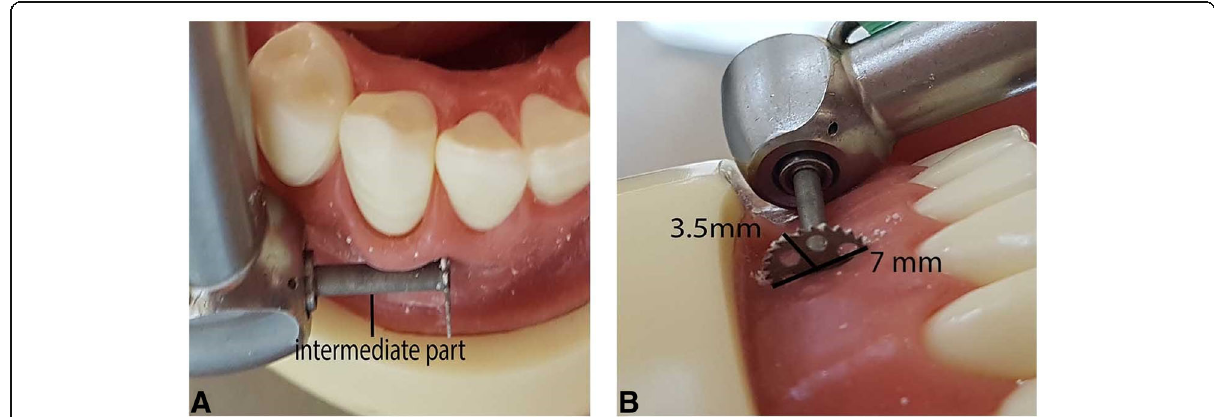
Fig. 3 a Controlled entry with a maximum depth of 3 mm. b Single entry-point with a 7 mm